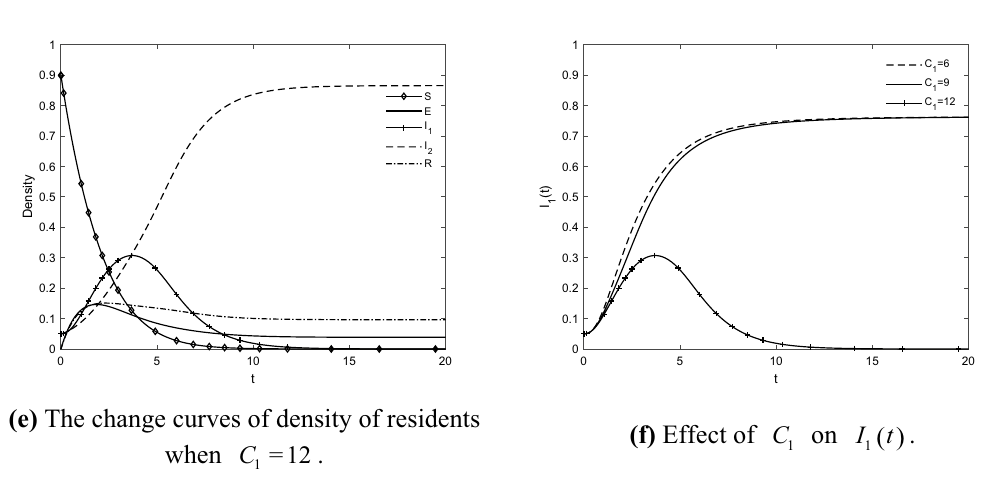
residents' strategy.